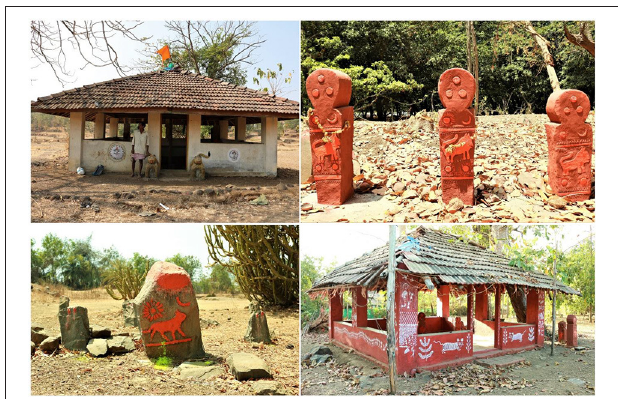
FIGURE 3 | Some variants of Waghoba shrines and idols documented across the study site.